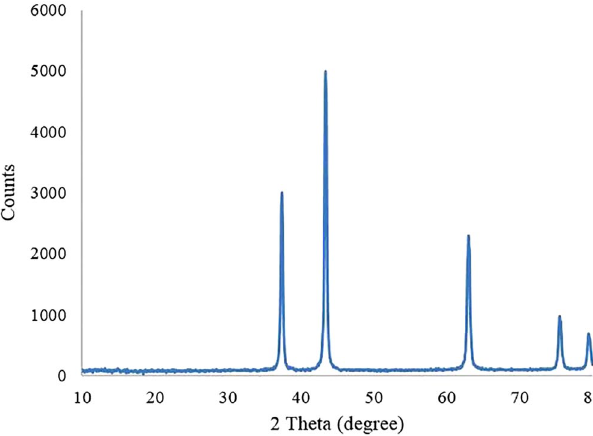
Figure 9. XRD pattern of S 5 after 4 runs catalytic reaction.